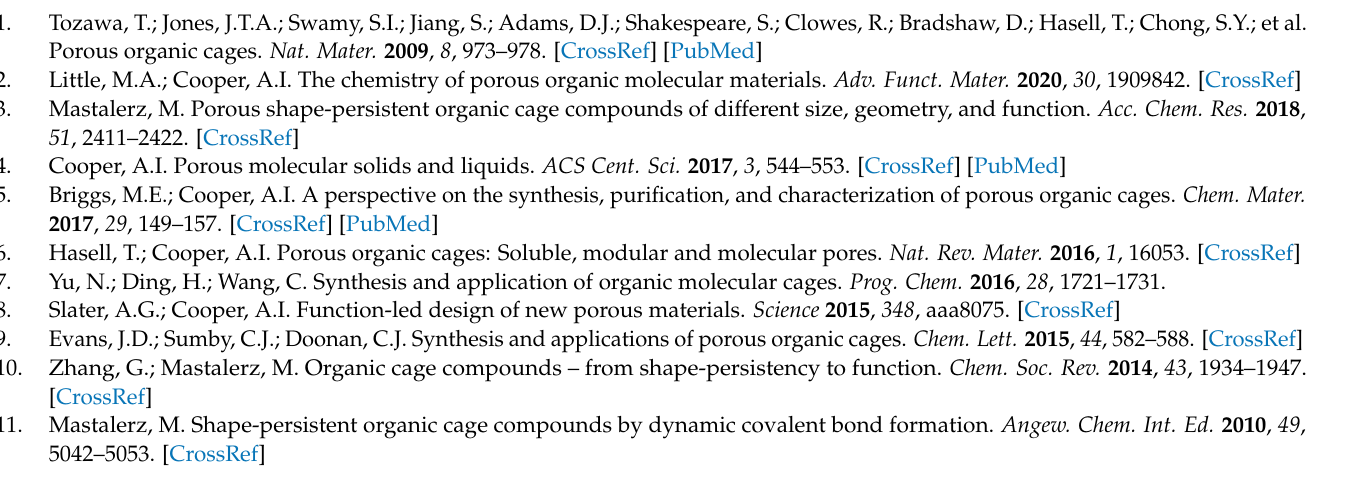
Figure S3: 31 P NMR spectrum of cage 3; Figure S4: Solid-state 31 P NMR spectrum of cage Iq-POC; Figure S5: Monoclinic space group C2 of cage 3; Figure S6: The PXRD spectrum of Iq-POC; Figure S7: N 2 sorption isotherms of Iq-POC measured at 77 K; Figure S8: Proposed catalytic mechanism; Figure S9: 1 H NMR copies of known